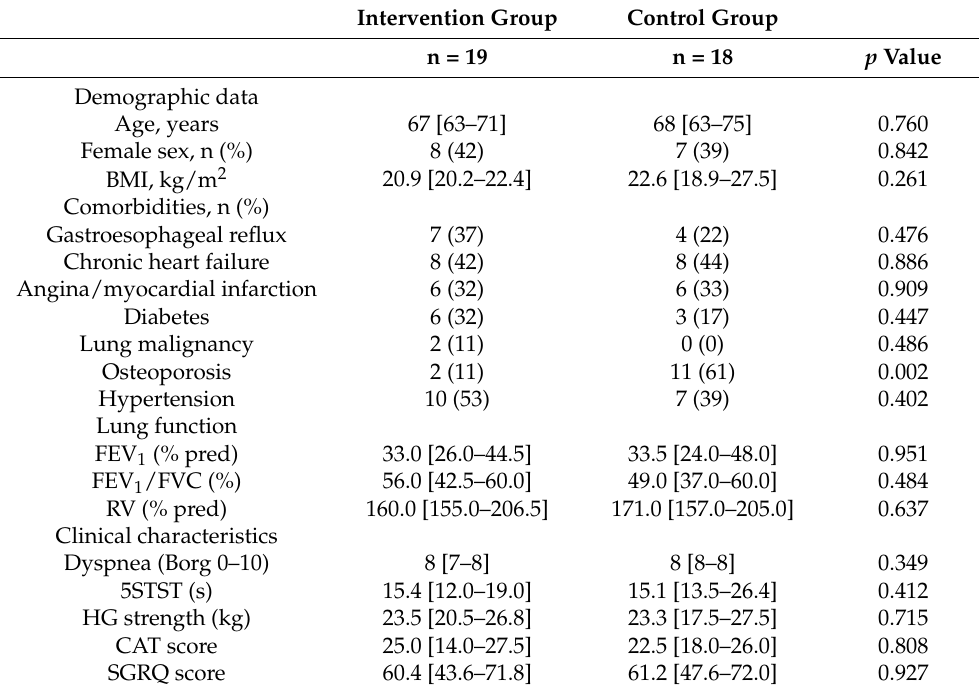
Table 1. Demographics and clinical parameters at